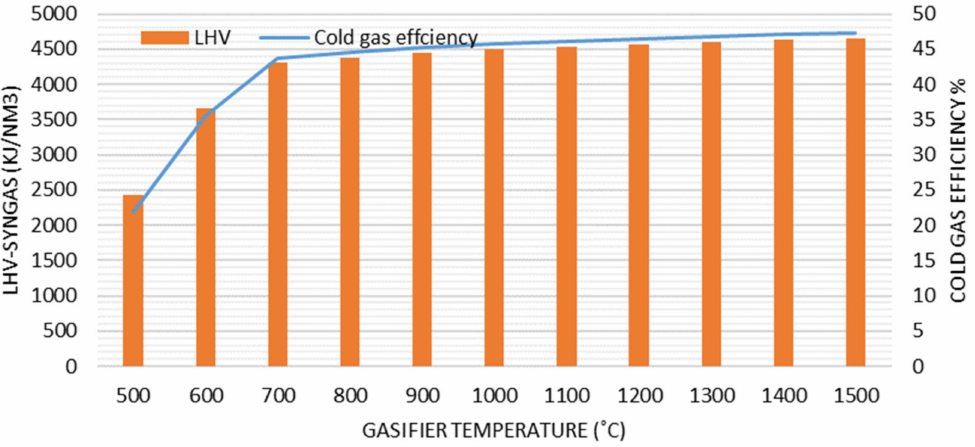
Figure 4. E ff ect of gasification temperature on syngas lower heating value (LHV) and cold gas e ffi ciency (CGE).